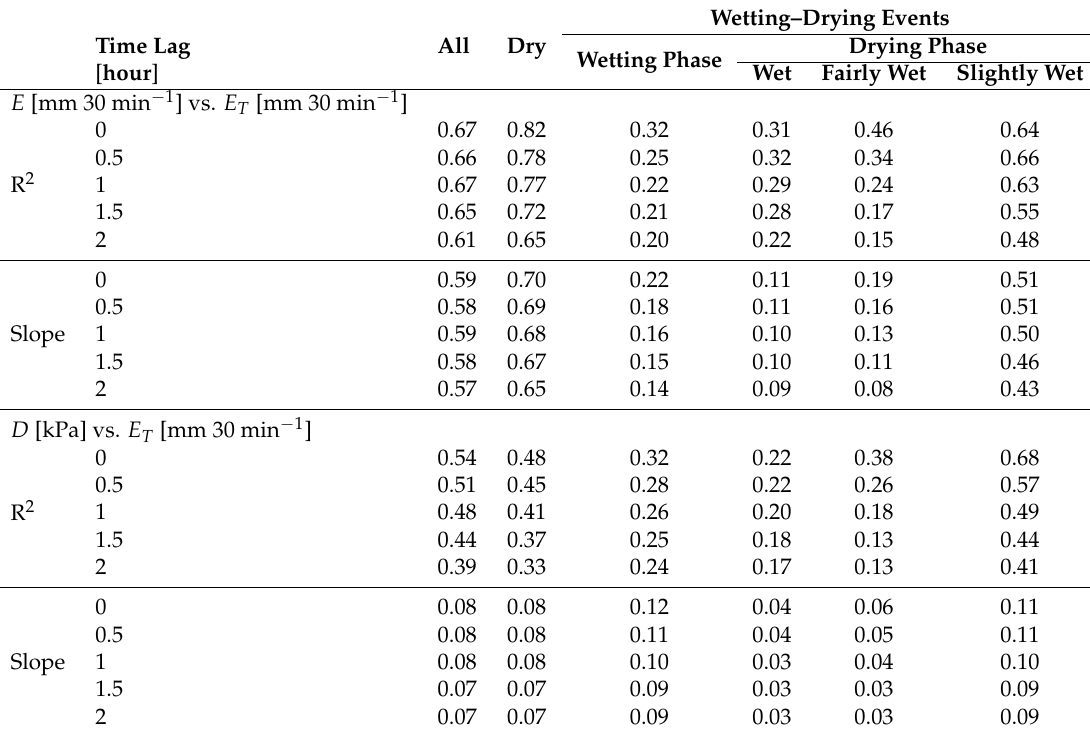
Table A2. Relationships of half-hourly E T measured using sap flow with E and D measured from the flux tower, under various canopy conditions and increasing values of time